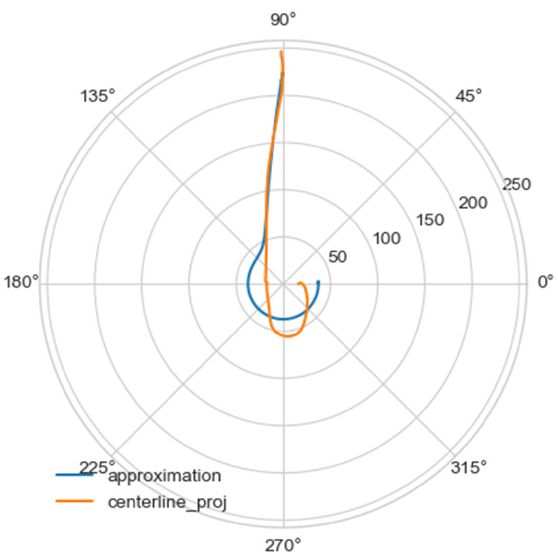
Figure 6. Comparison of a flat projection of the central line of the aorta and its approximation by a spiral in polar coordinates. The orange line is the projection of the central line, the blue line is the fitting curve.